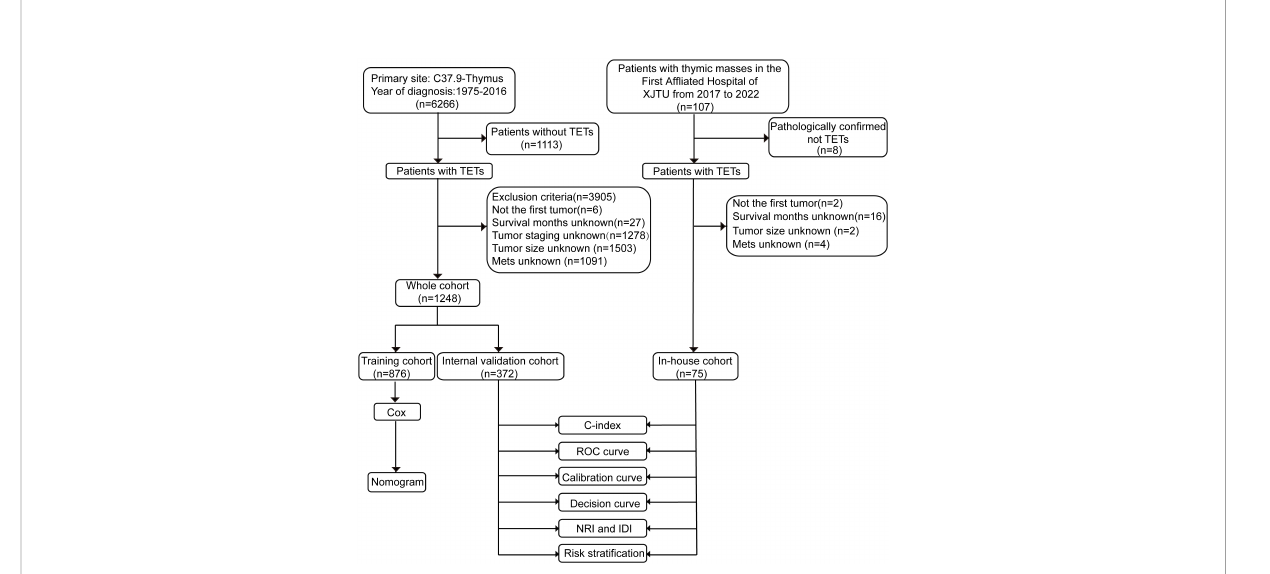
FIGURE 1 Flow chart of the study. ROC curve, receiver operating characteristics curve; NRI, net reclassi fi cation index; IDI, integrated discrimination improvement. TETs, thymic epithelial tumors; XJTU, Xi ’ an Jiaotong University; Mets, metastasis; C-index, the consistent